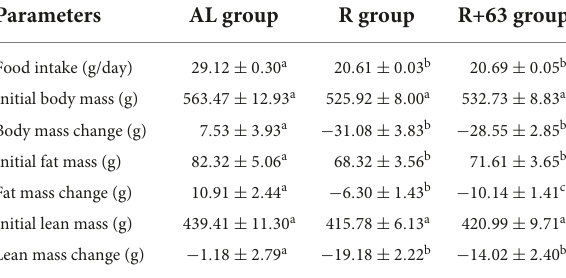
TABLE 4 Food intake, initial body mass, change in body mass, initial fat mass, change in fat mass, initial lean mass, and change in lean mass in the “frail” rat model during experiment #2.